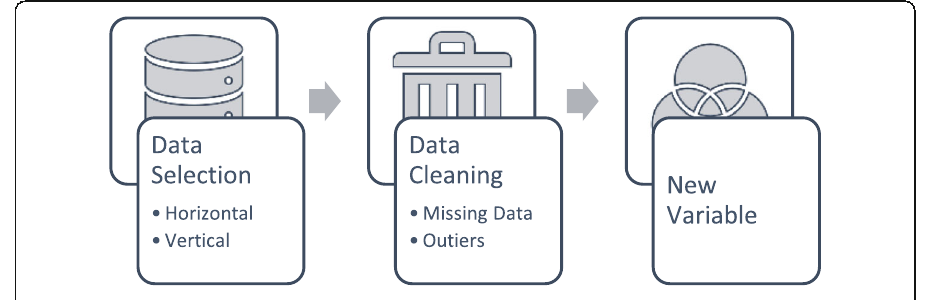
Fig. 6 Initial Preparation of